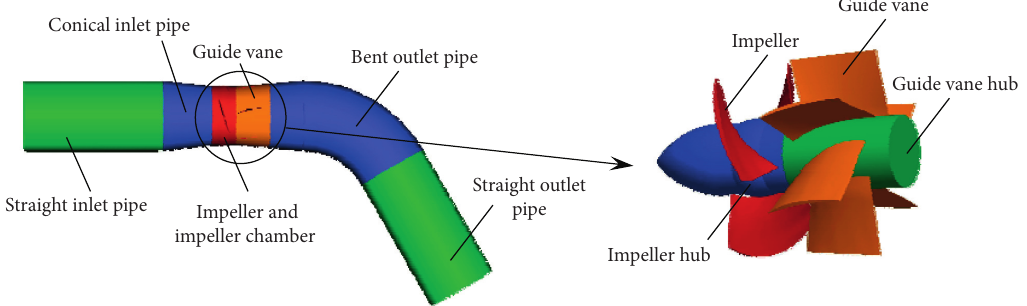
Figure 1: Computational domain for an axial flow